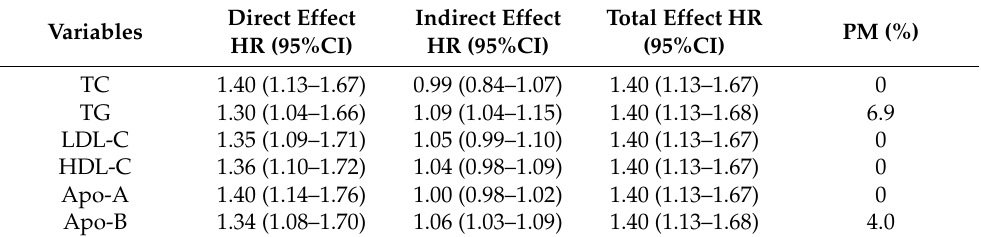
Table 3. Mediation analysis of the association between the ABCB1 rs4148727 and T2DM risk mediated by lipid